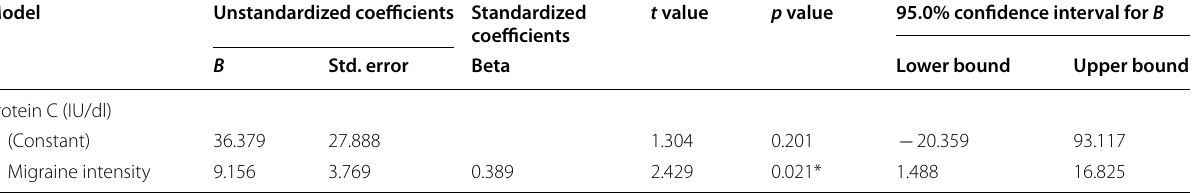
Table 7 Regression analysis to detect predictive value of protein C in migraine patients